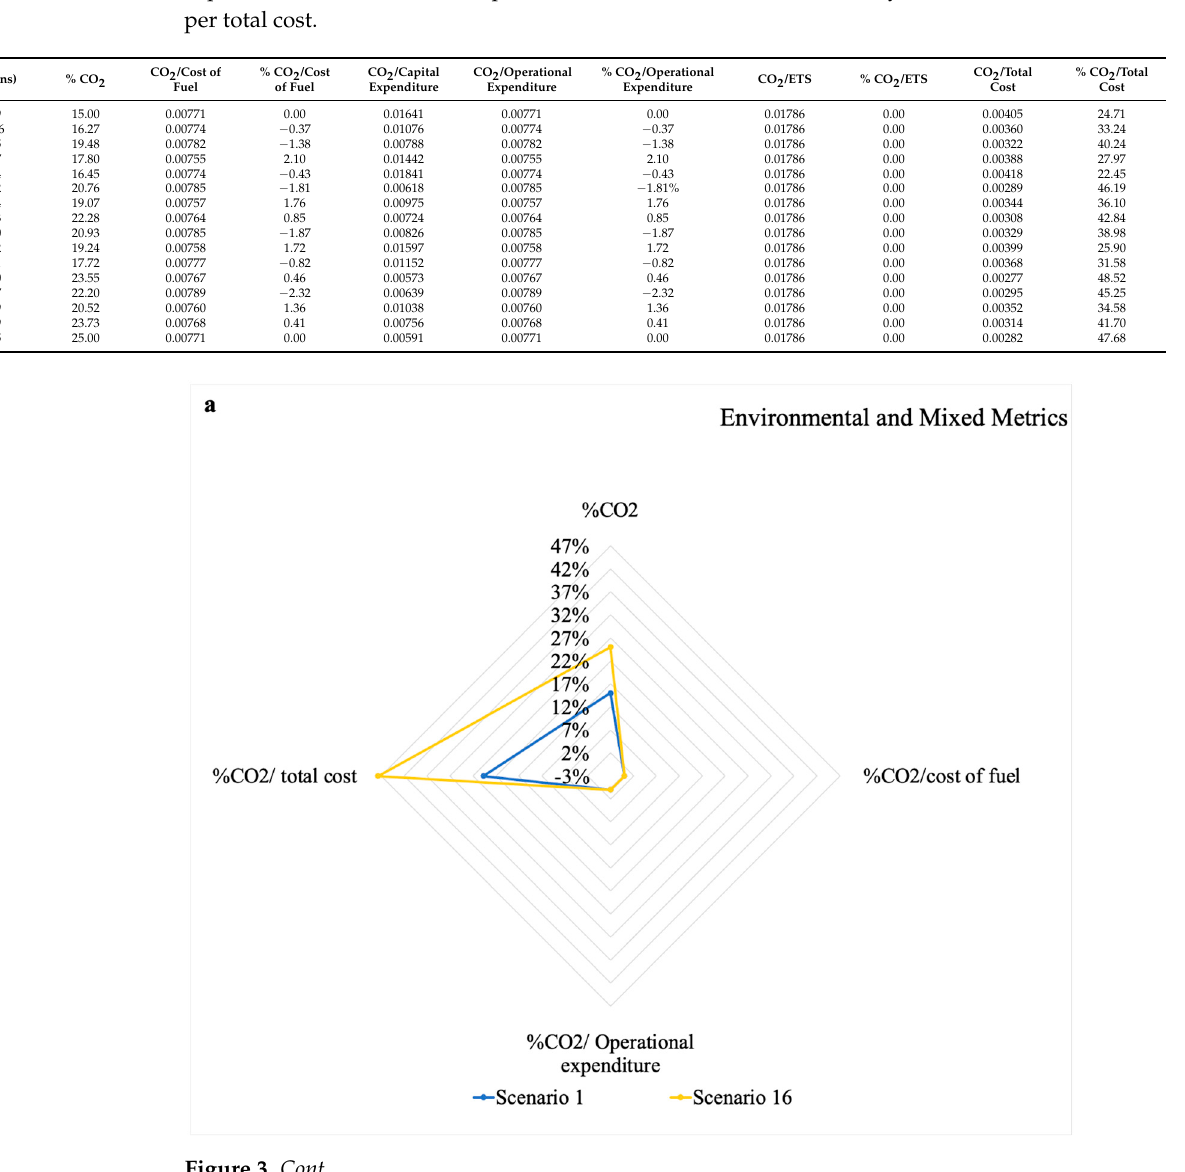
Table 8. Absolute values and percentages when compared to the respective values from the refer- ence scenario for all scenarios, starting from carbon emissions in tons, carbon emissions per cost of fuel consumption, carbon emissions per capital expenditure, carbon emissions per operational ex- penditure, carbon emissions per cost of the defined emissions trade system and carbon emissions per total cost.